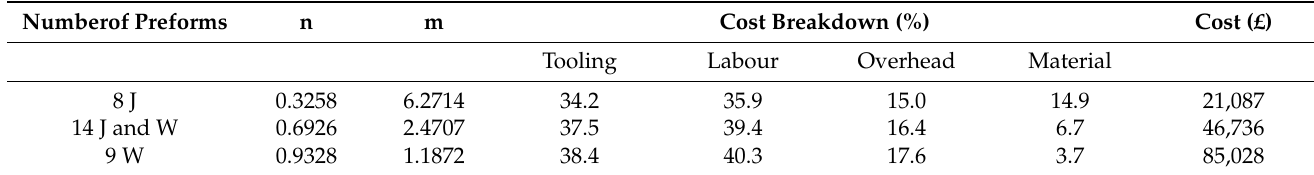
Table 10. Quoted preform cost: cost breakdown (%) and total